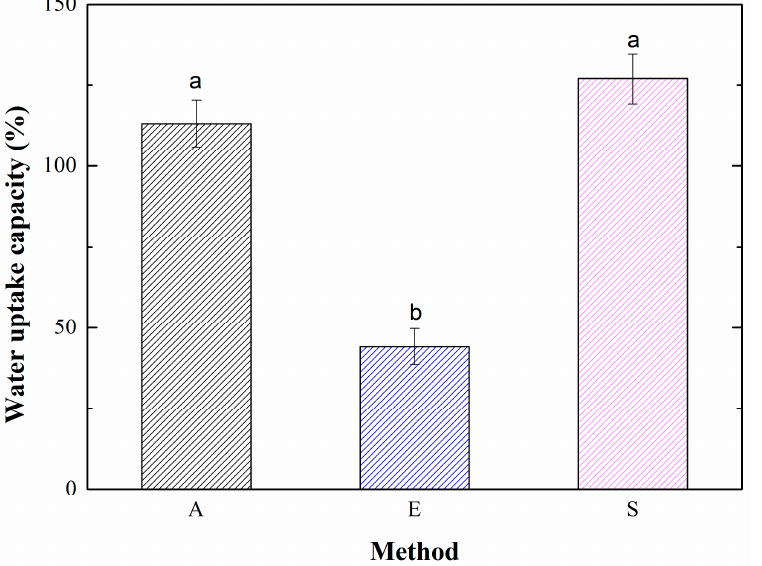
Figure 4. Water uptake capacity of the matrices processed by the different protocols. Different letters mean significant differences.